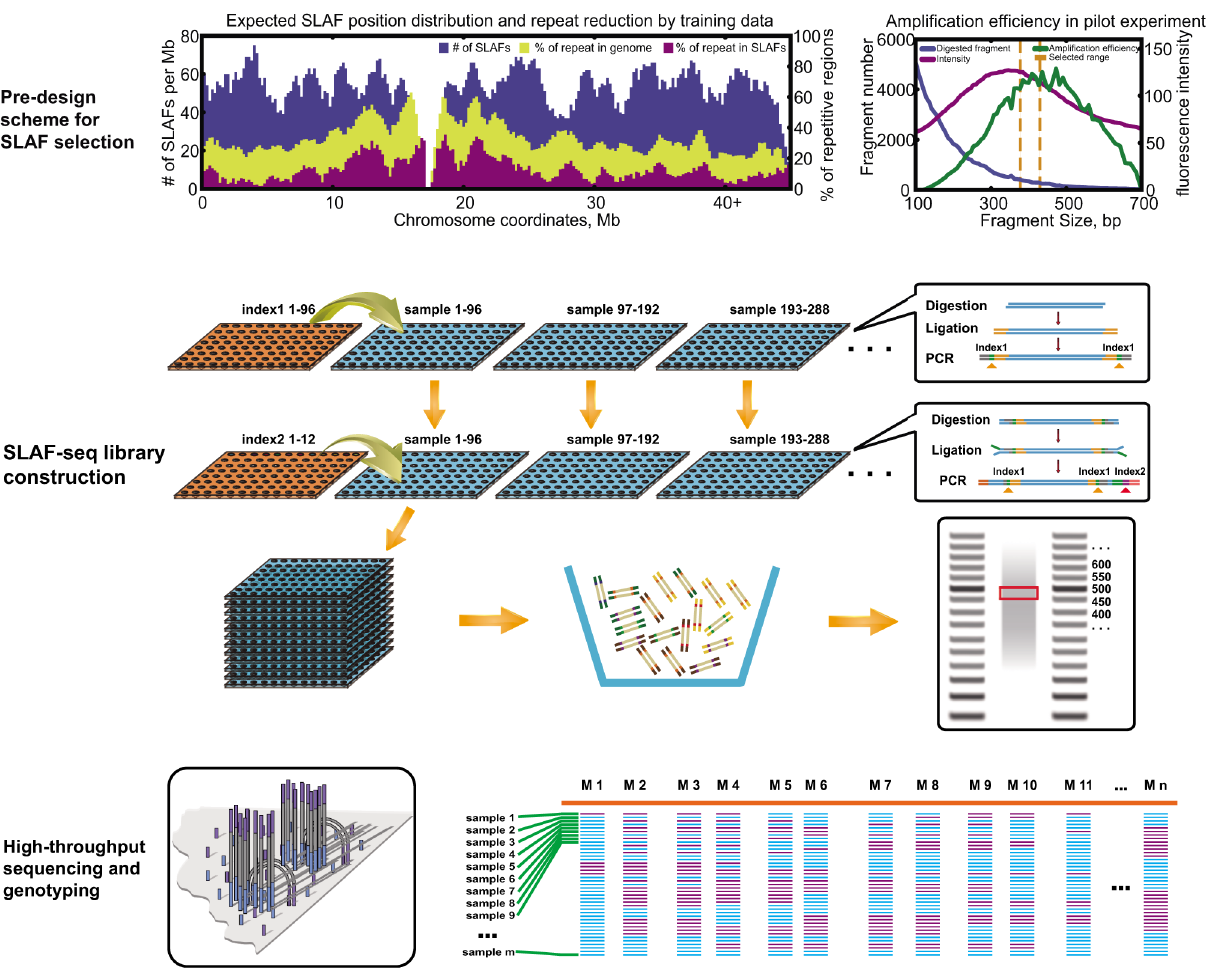
Figure 1. SLAF-seq flowchart. i) Pre-design scheme for SLAF selection using training data. The reduced representation design must be decided based on marker efficiency characteristics, which include random distribution throughout the genome, uniqueness in the genome, and consistent amplification efficiency among selected markers. A pilot experiment was performed to evaluate the amplification efficiency based on the pre- designed scheme. ii) SLAF-seq library construction. Genomic DNA was digested by groups of enzymesdesigned for individuals. Double barcodes were added to two round PCR reactions to discriminate each individual and to facilitate the pooling of samples for size selection, which maintained consistent fragment size among individuals. iii) Deep sequencing for the pooled RRLs with the Illumina paired-end sequencing protocol, and genotype definition and validation by software.